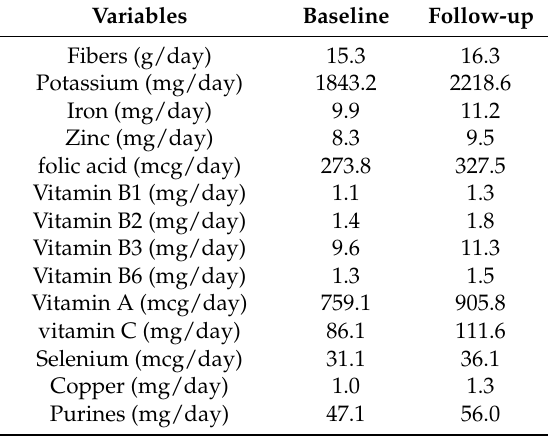
Table A2. Mean values of the intake of additional macro and micronutrients, which significantly increased in the whole population (156) at baseline and follow-up after nutritional intervention ( p <